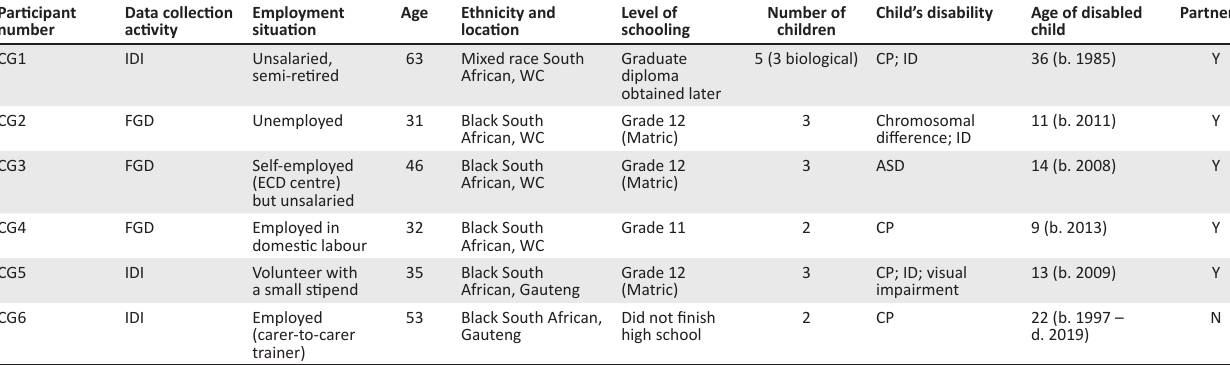
TABLE 1: Participant characteristics and